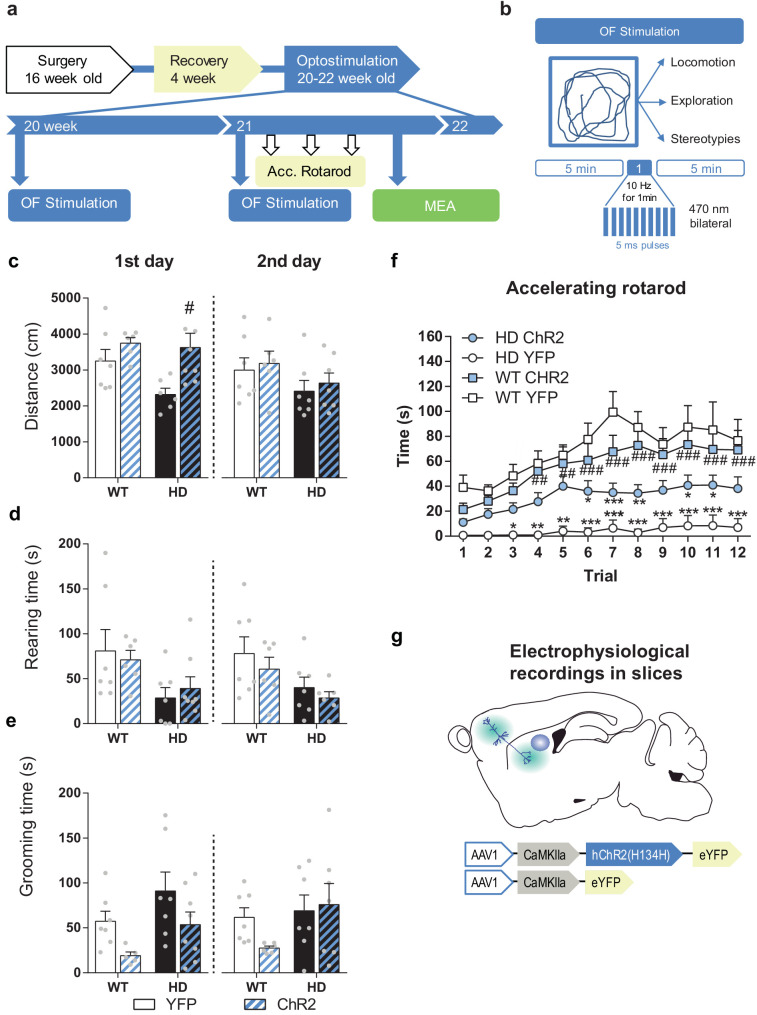
Behavioral data generated in mice used for Figure 6a–e.(a) Surgery, behavior, and optogenetic experimental timeline. The OF procedure was performed at 20 (1st day OF) and 21 (2nd day OF) weeks old mice. After 2nd stimulation day, motor learning tests were performed, and mice were sacrificed for electrophysiological analyses in brain slices. (b) Optogenetic stimulation consisted of 10 Hz light stimulation for 1 min during open field (OF) task and spontaneous activity was scored. (c) Locomotion (distance traveled), (d) exploration time (rearing time), and (e) stereotypic grooming (grooming time) were evaluated during the first (left) and second (right) open field sessions. (f) Latency to fall in the accelerating rotarod task. (g) Schematic diagram showing AAV-ChR2 and control AAV-YFP constructs injections at the M2 cortex and electrophysiological evaluation in sagittal cortico-striatal slices. Values are expressed as mean ± SEM (WT-YFP n = 7, WT-ChR2 n = 9, HD-YFP n = 7, and HD-ChR2 n = 8 mice). Each point represents data from an individual mouse. Data were analyzed by two-way ANOVA with genotype and light stimulation as factors, and Bonferroni test as a post hoc. *p < 0.05, **p < 0.01, and ***p < 0.001 versus WT-YFP and #p < 0.05 ##p < 0.01 and ###p < 0.001 versus HD-YFP.